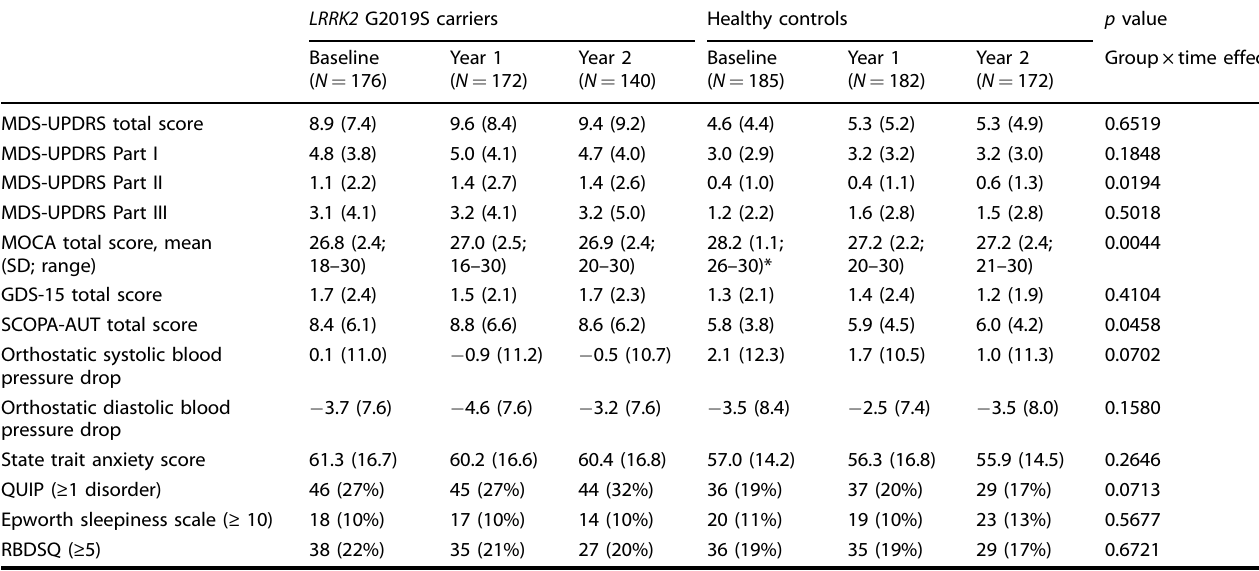
Table 2. Change in clinical characteristics among LRRK2 G2019S carriers vs healthy